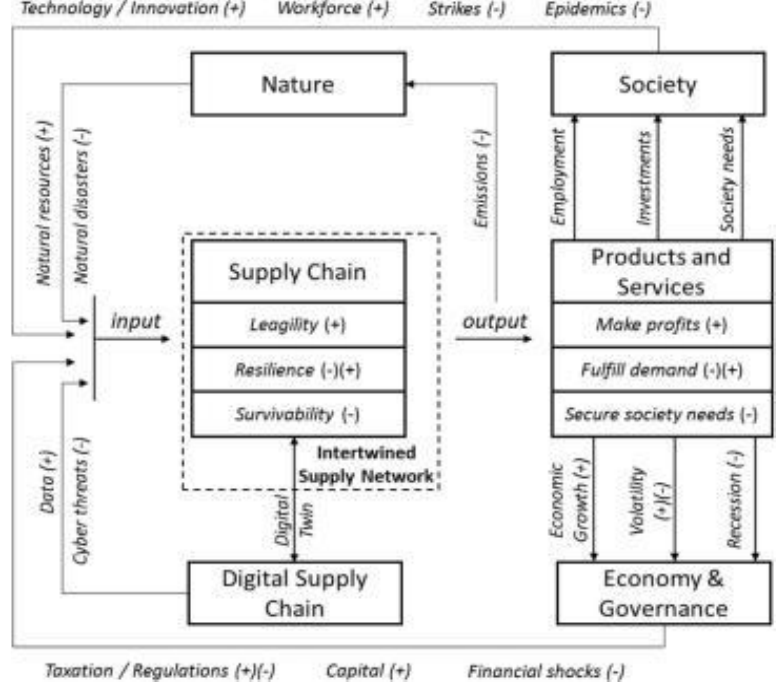
Figure 2. A General Framework of a Supply Chain